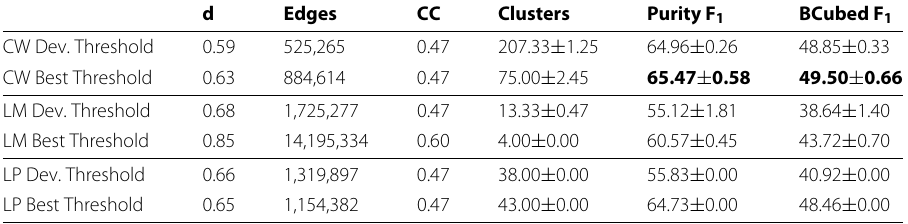
Table 9 Semantic role induction results on the test data d Edges CC Clusters Purity F 1 BCubed F 1 CW Dev.